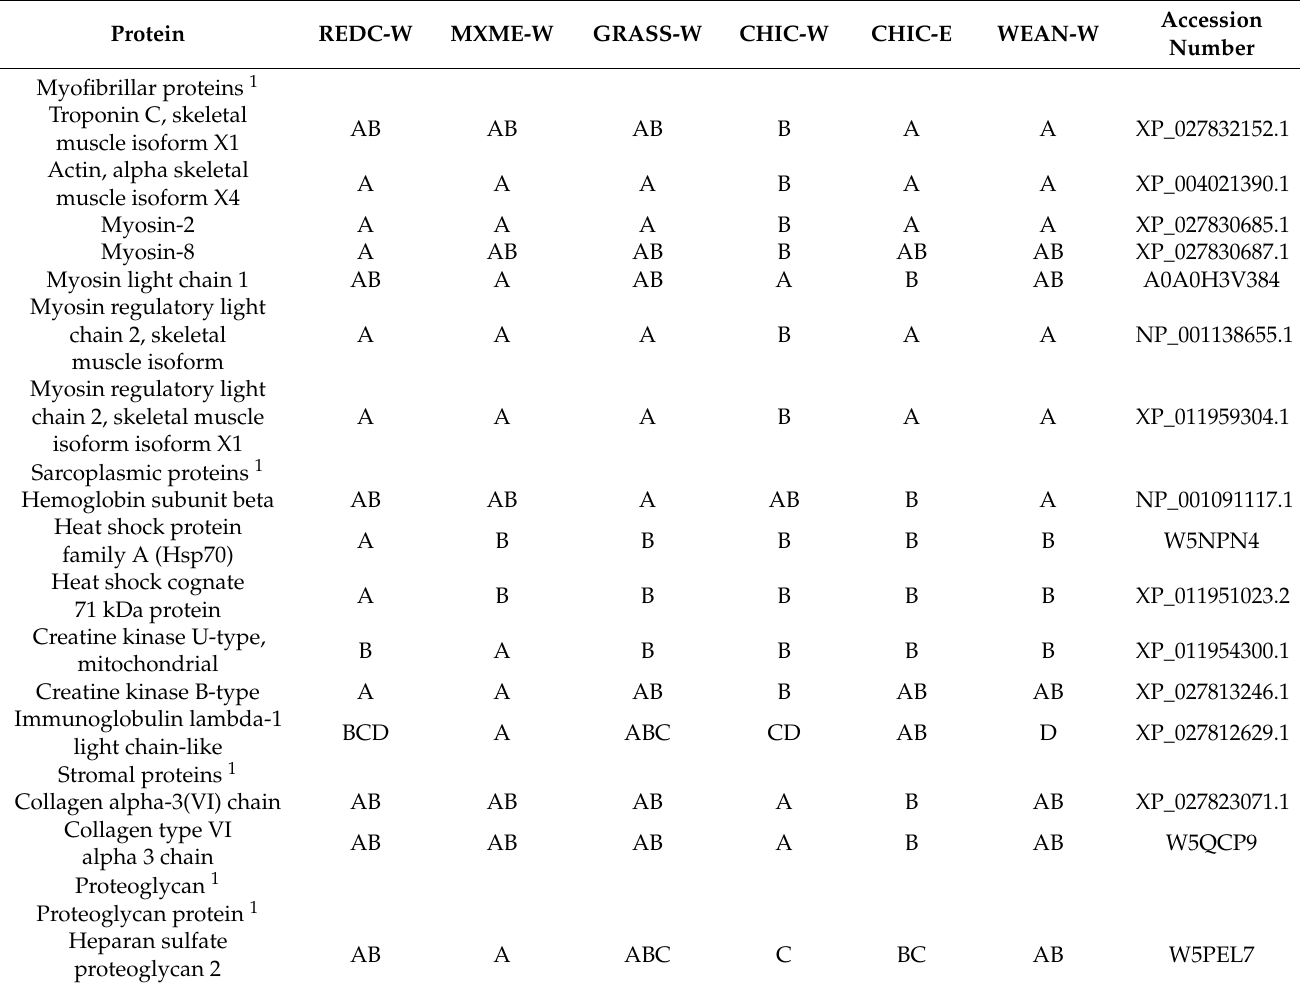
Table 2. Identified myofibrillar, sarcoplasmic, stromal, and proteoglycan proteins from raw lamb longissimus lumborum muscle that significantly differed between commercial forage production systems using a negative binomial model. A complete list of all identified proteins is presented as supplementary material (Table S1). n = 8 for REDC-W, n = 7 for MXME-W, n = 6 for GRASS-W, n = 6 for CHIC-W, n = 7 for CHIC-E, and n = 7 for